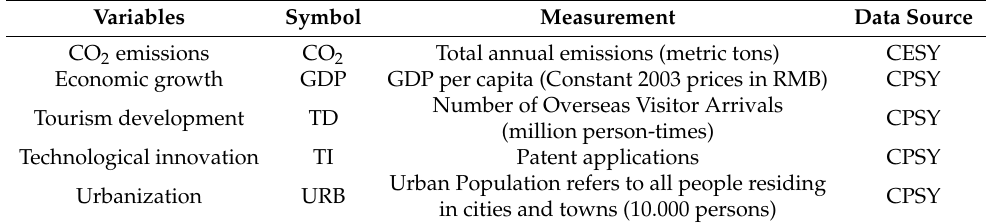
Table 1. Variable’s measurement, symbol, and data source. Variables Symbol Measurement Data Source CO 2 emissions CO 2 Total annual emissions (metric